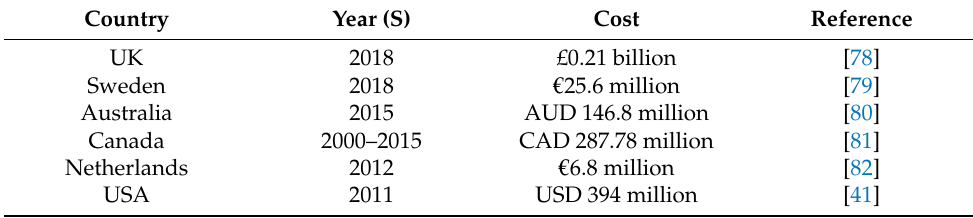
Table 5. Cost of illness studies on